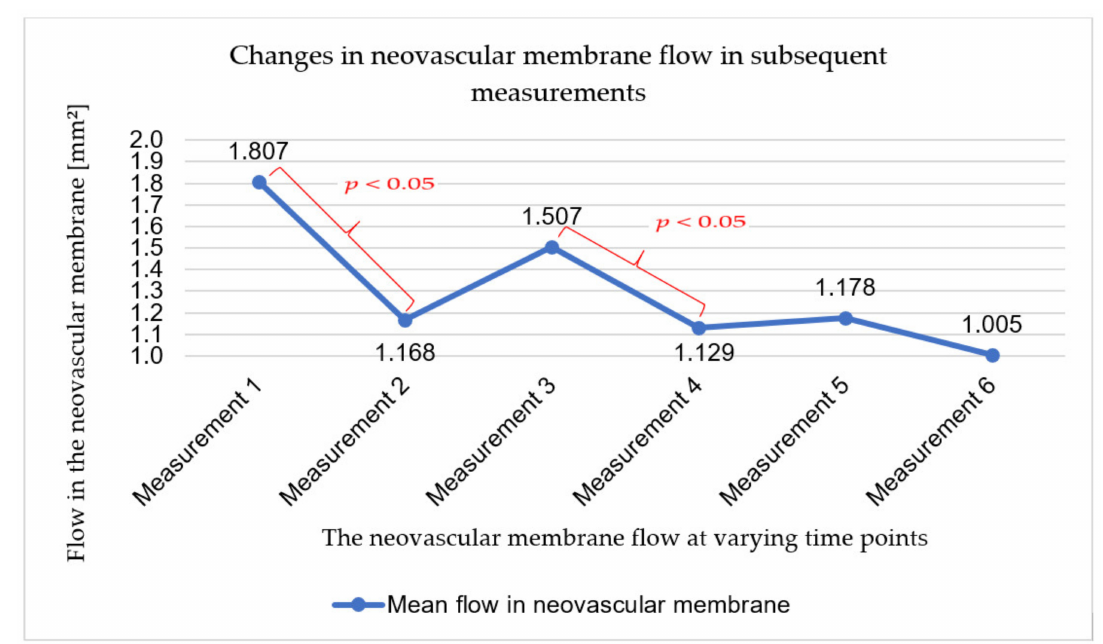
Figure 4. Changes in neovascular membrane flow in subsequent measurements. Color indicates statistically significant differences between two consecutive